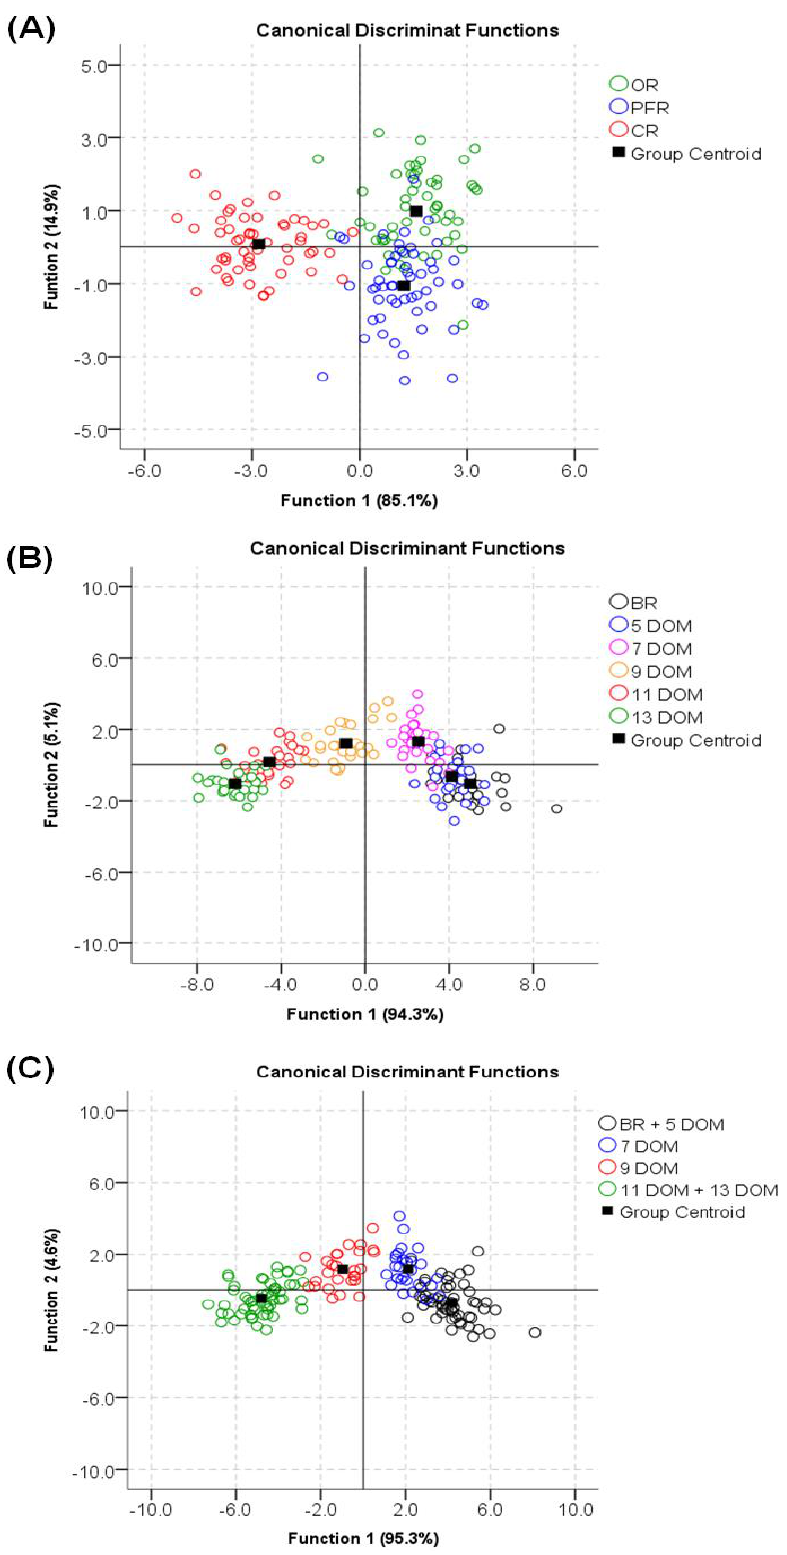
Figure 9. Stepwise discriminant analysis (SDA) using the FA, vitE, and phenolic metabolite contents measured in rice grain. ( A ) rice type identification, ( B ) six levels of DOM identification, ( C ) four levels of DOM identification.